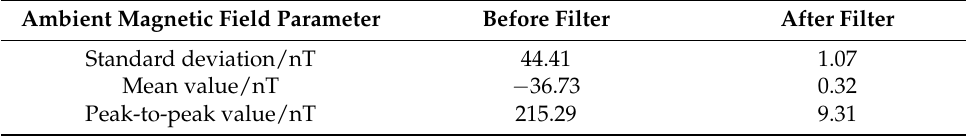
Table 1. Comparison of the ambient magnetic field before/after